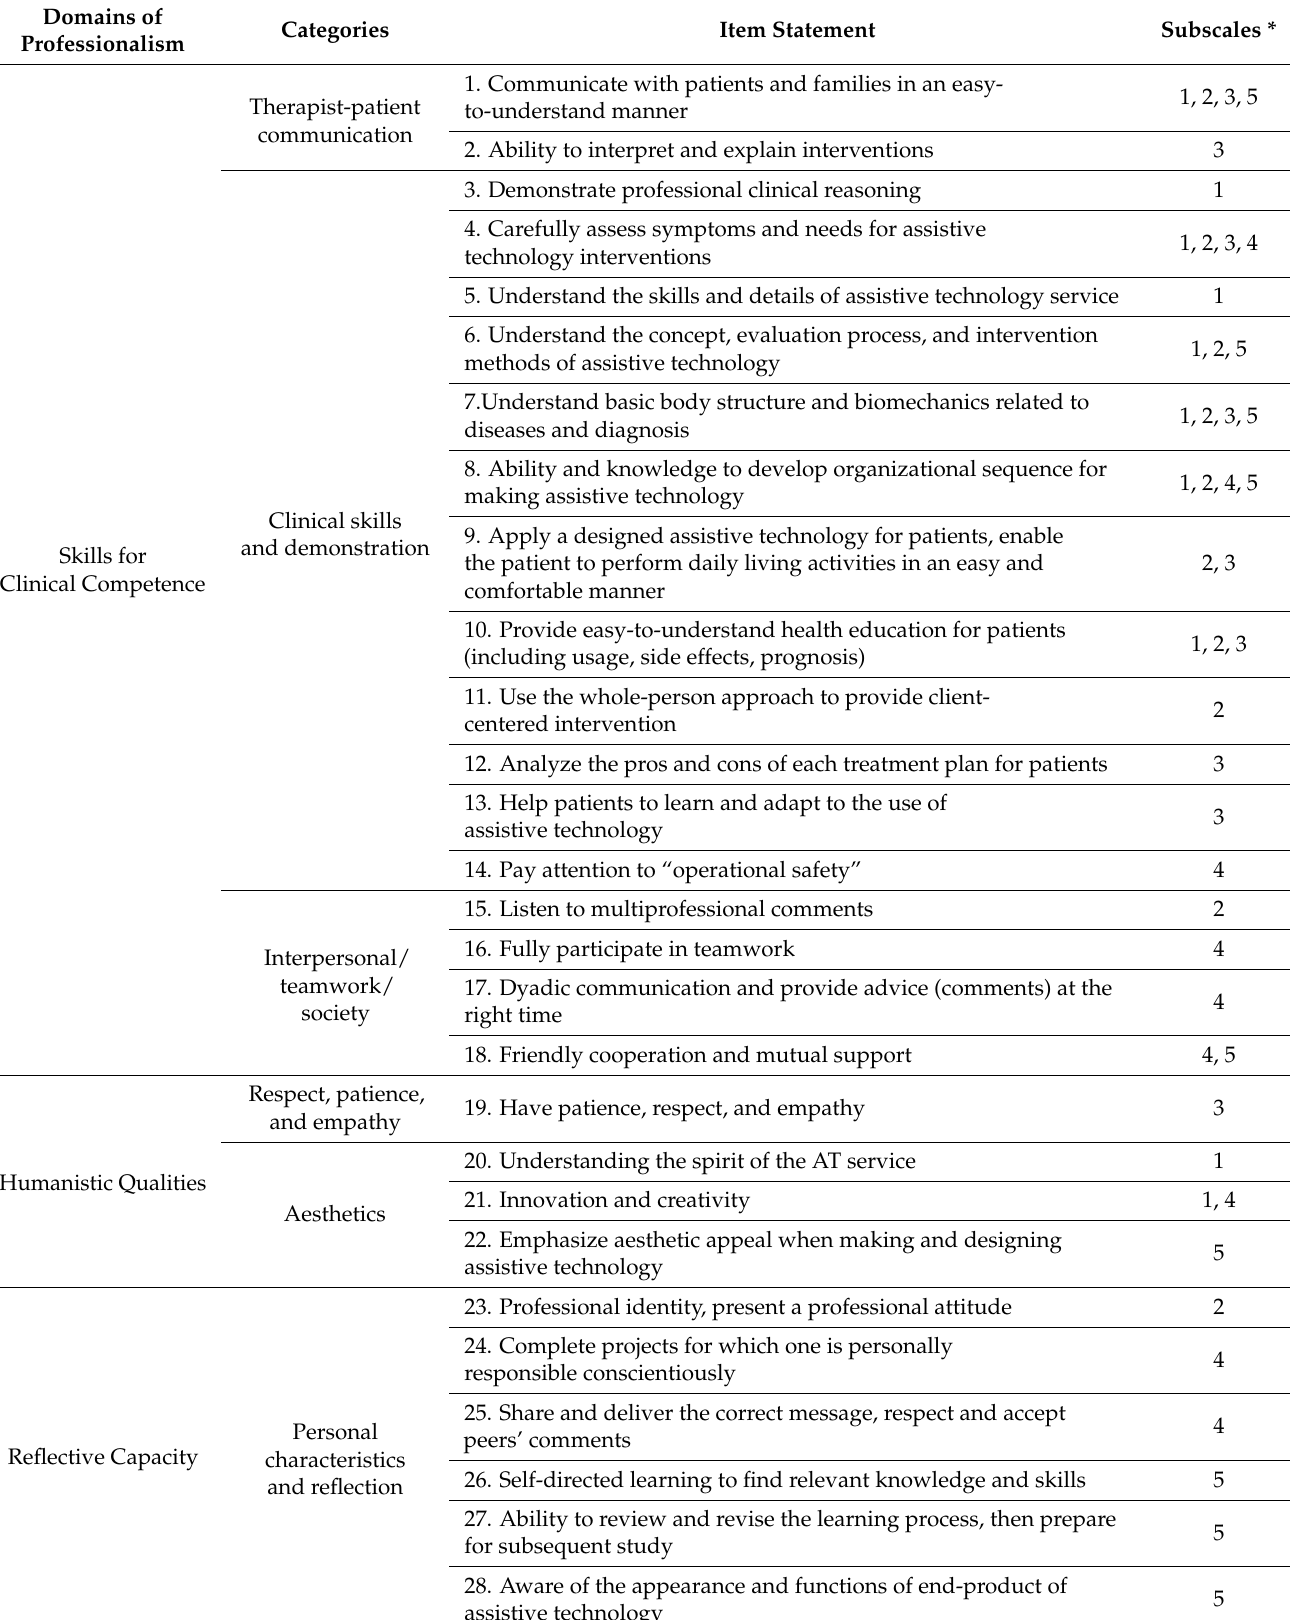
Table 5. Final items included on the MPC after the Delphi